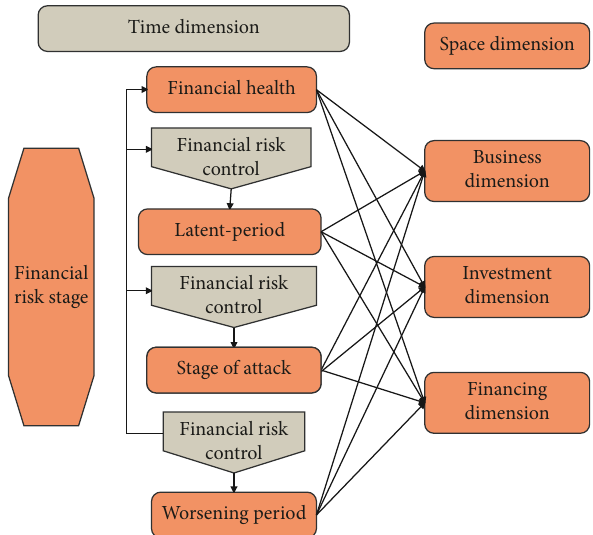
Figure 2: “Spatiotemporal” characteristic analysis of financial risk in colleges and universities.